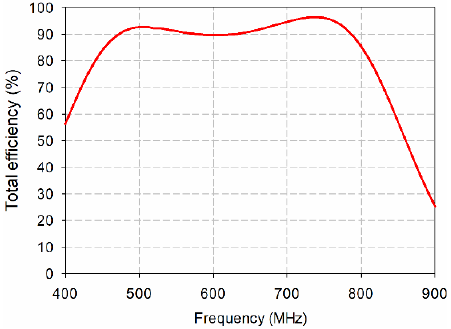
Figure 12. Simulated total efficiency of the proposed antenna.